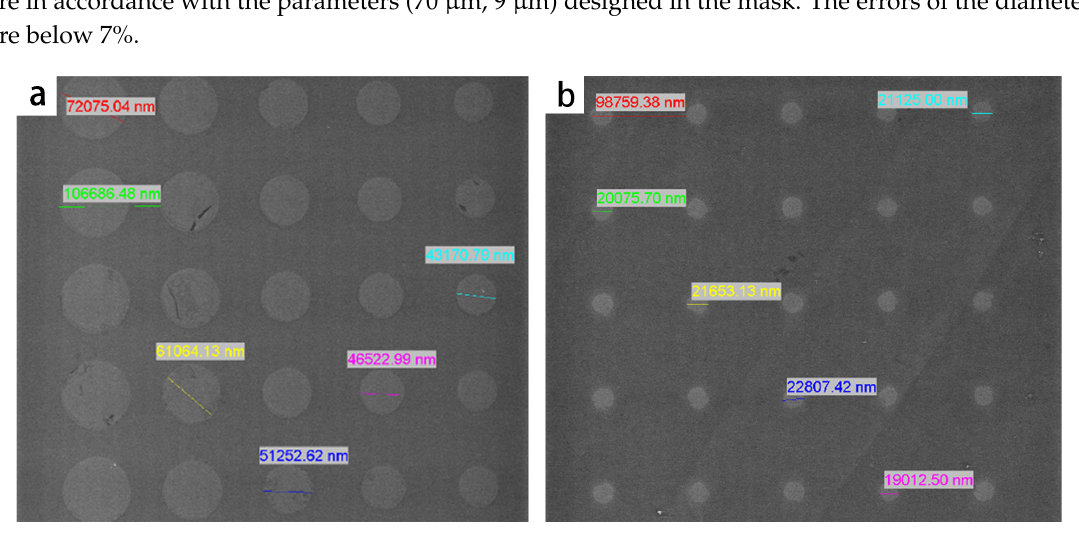
Figure 6. Prepared substrate observed by the scanning electron microscope. ( a ) The large patterns with diameters from 42 µ m to 72 µ m. ( b ) The small patterns with diameters around 20 µ